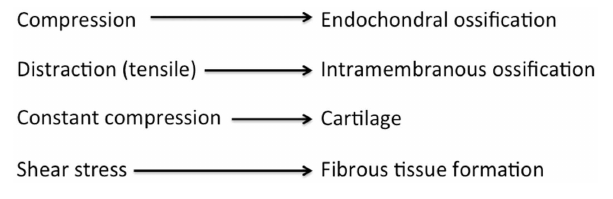
FIGURE 7 | Diagram showing the process of osteogenesis by different mechanical environments . Adopted from Chao and Inoue (75).